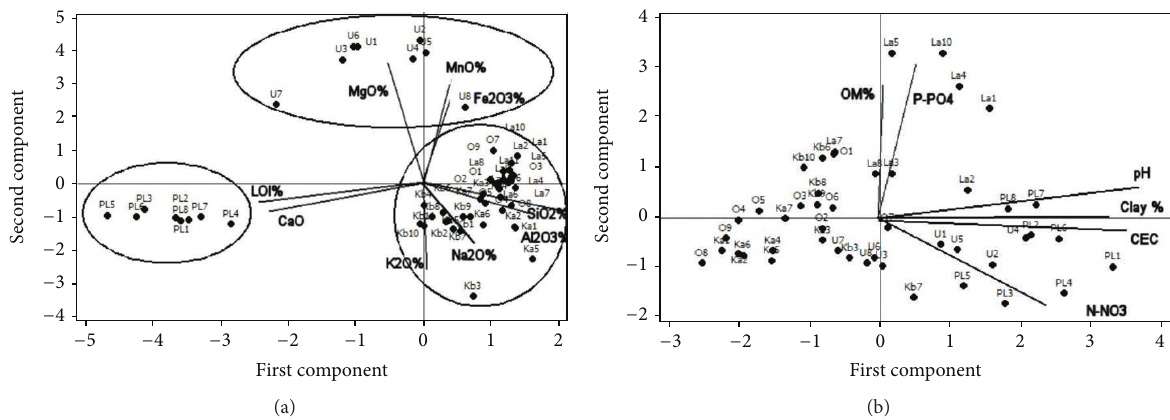
Figure 2: (a) PCA of chemical analysis (Na 2 O, MgO, K 2 O, Fe 2 O 3 , MnO, CaO, Al 2 O 3 , SiO 2 , and LOI). (b) PCA of macronutrients availability (N-NO 3 , P-PO 4 ) and physical parameters (clay content: clay%, organic content: OC%, and cation exchange capacity: CEC). 54 soil samples from Omalos Plateau (O), Lasithi Plateau (La), Kantanos (Ka, Kb) Anogia (U), and Platanos (PL). Variable axes are depicted in the